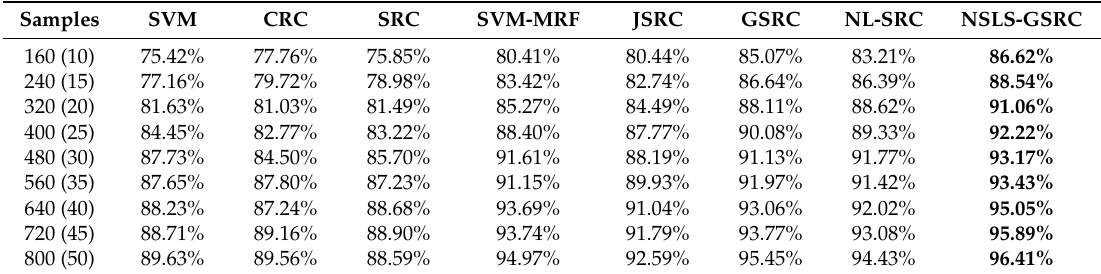
Figure 8. Overall classification accuracy obtained by the different tested methods versus different number of labeled samples for the AVIRIS Indian Pines scene. Table 4. Overall accuracies (in percent) obtained by the different tested methods using different number of labeled samples (per class) for the Salinas scene. The best results are in bold.